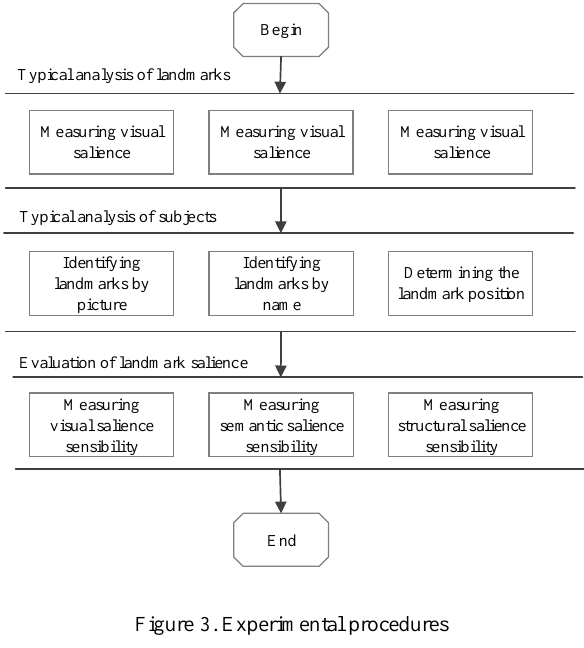
Figure 3. Experimental